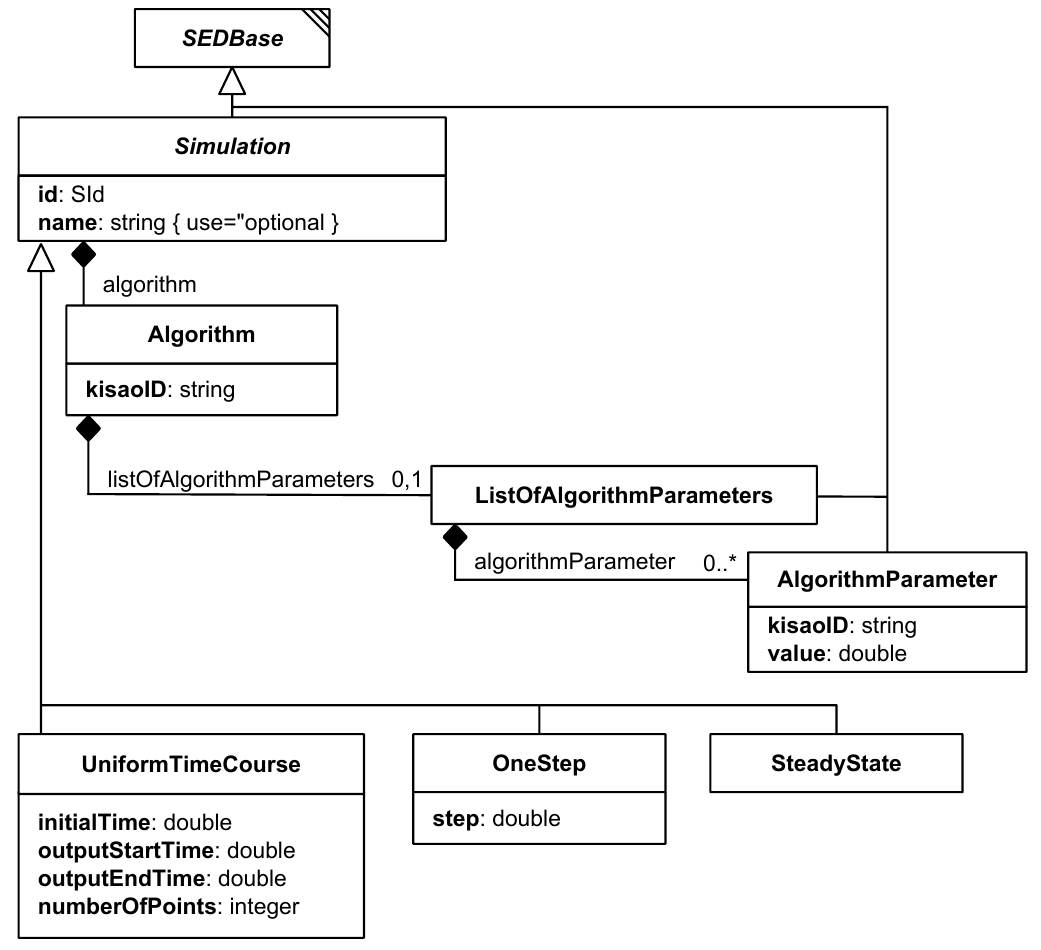
Figure 2.11: The SED-ML Simulation